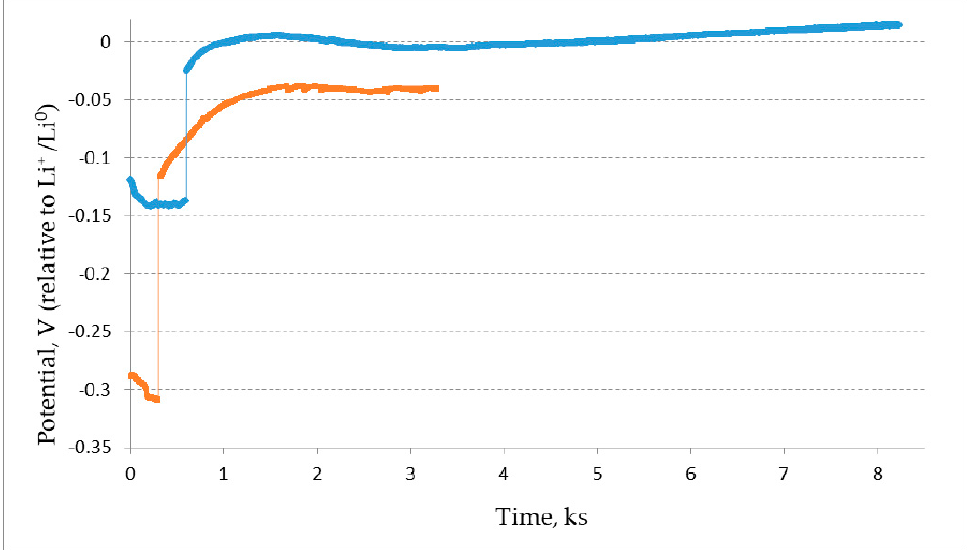
Figure 5. Change in the cathode potential relative to Li + /Li 0 at the current interruption after 300 s (orange) and 600 s (blue) of the electrolysis at the current load of –0.4 A and –0.25 A, respectively. Q exp /Q theor is equal to 17% and Q exp /Q theor is equal to 136%. A Nd 2 O 3 pellet was used.